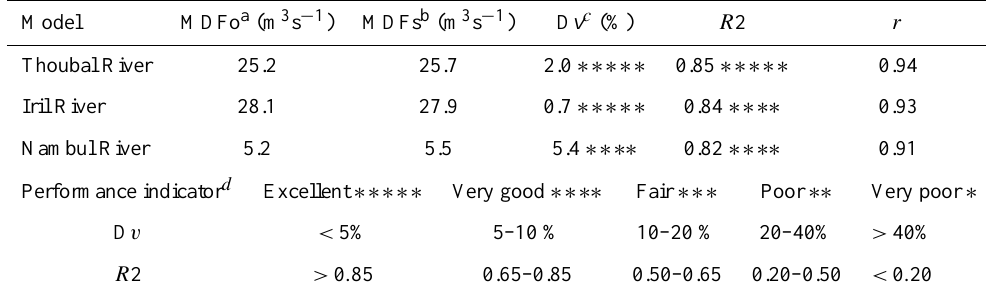
Fig. 3. Observed and simulated mean monthly discharge for the three modelled sub-catchments (June 1999–May 2003) (a) Thoubal, (b) Iril, (c) Nambul. Table 3. Statistical measures of model performance.